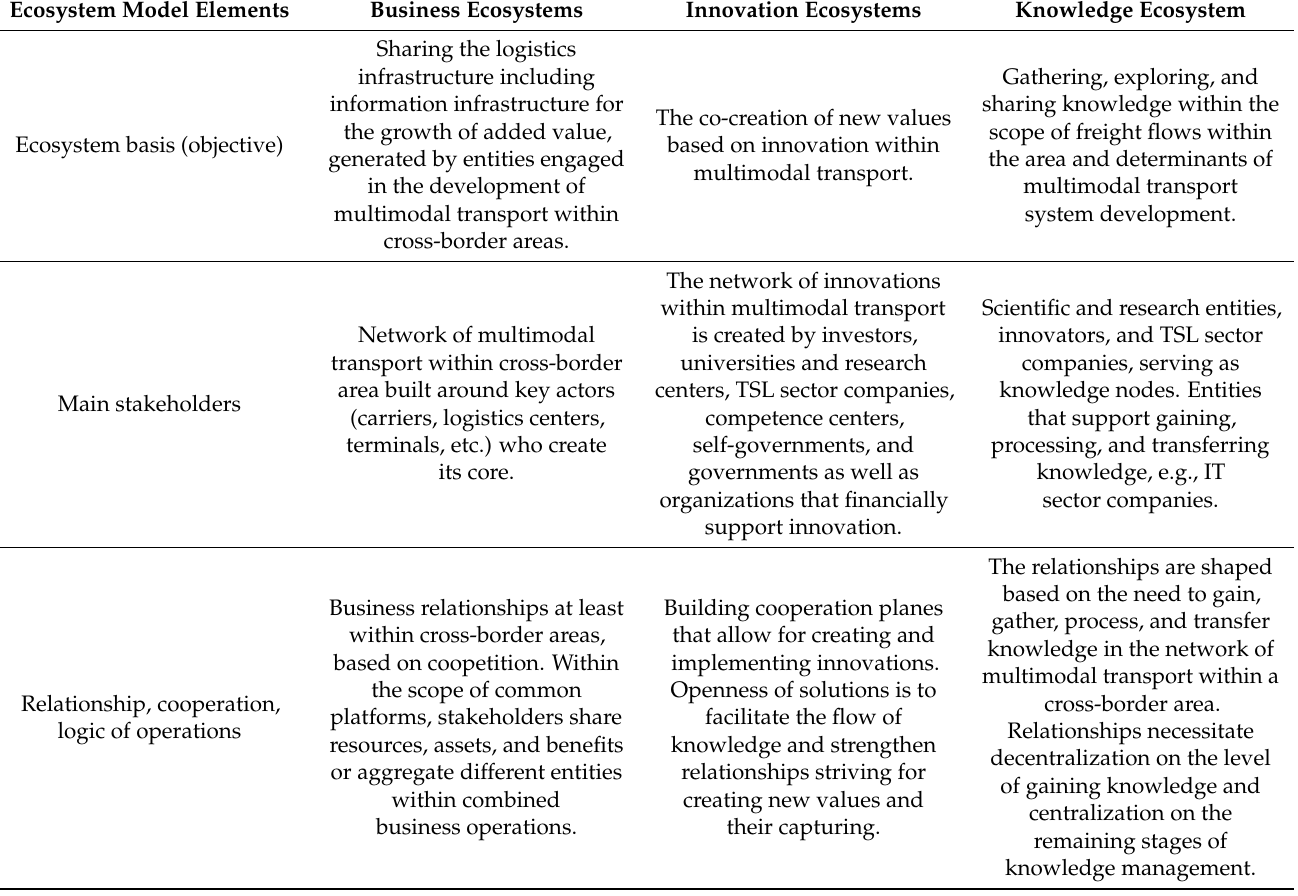
Table 3. Assumptions of the multimodal transport ecosystem